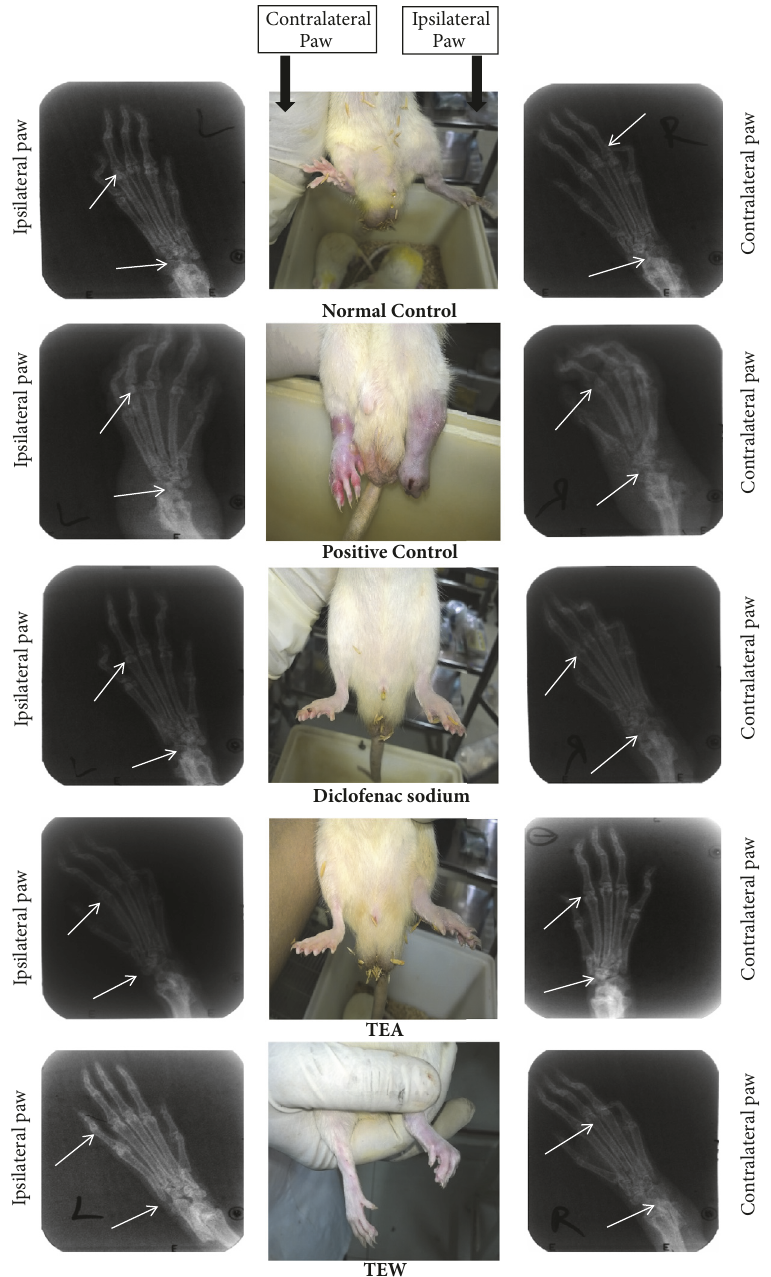
Figure 6: Effect on radiological changes; diclofenac sodium was used as a standard drug and the effect of ethanolic and water extracts of T. tomentosa was compared with disease control, where the plant extract significantly reduced the inflammation in the treatment